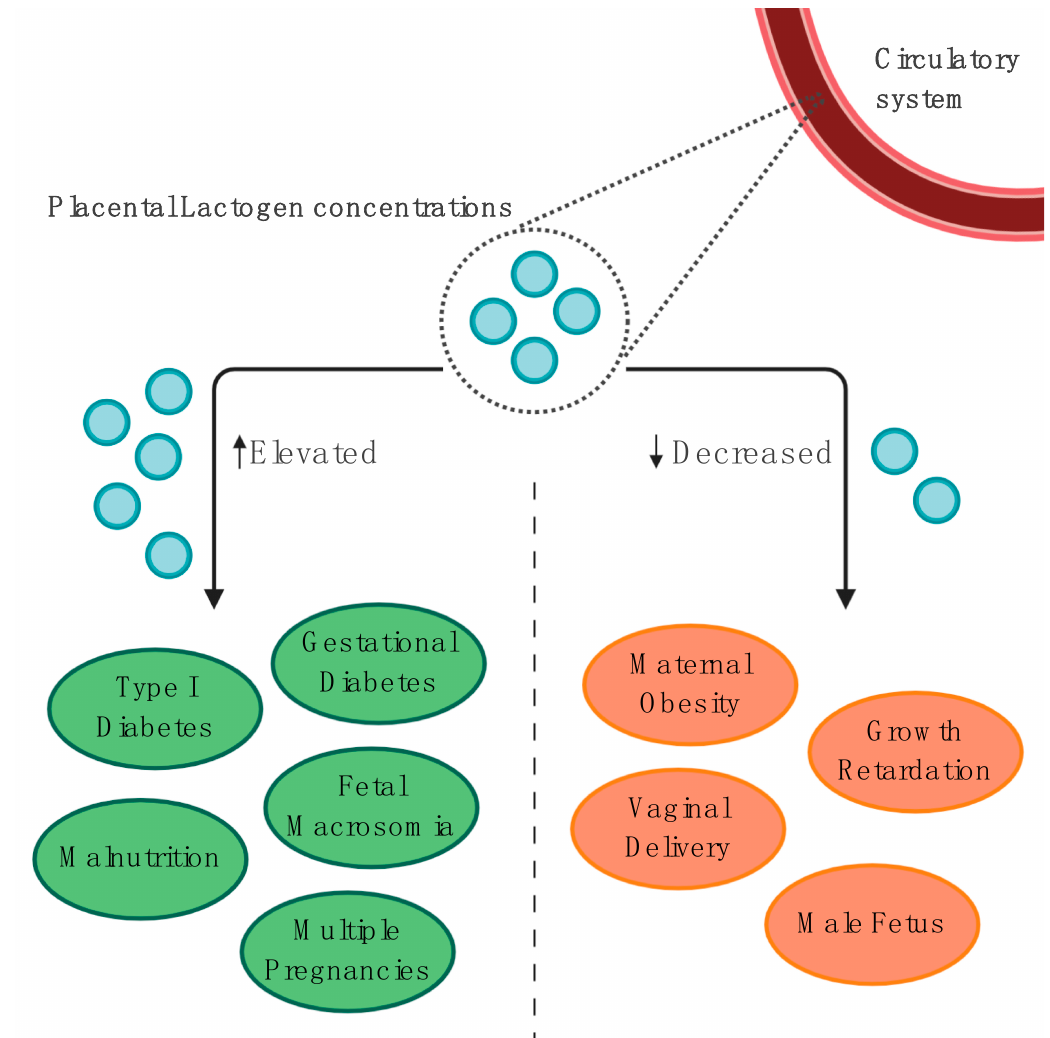
Figure 3. The summary of clinical conditions associated with elevated and decreased placental lactogen blood levels [49–51,61,65–67,86–91,94,99]. Created with BioRender.